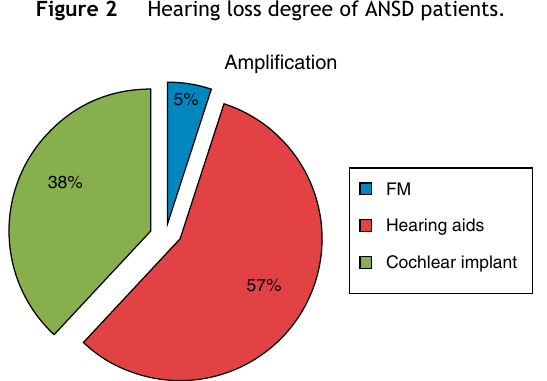
Figure 2 Hearing loss degree of ANSD patients.